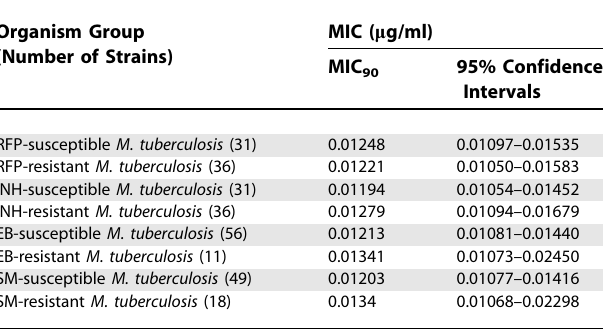
Table 3. MIC 90 of OPC-67683 against Drug-Susceptible and Drug-Resistant M.